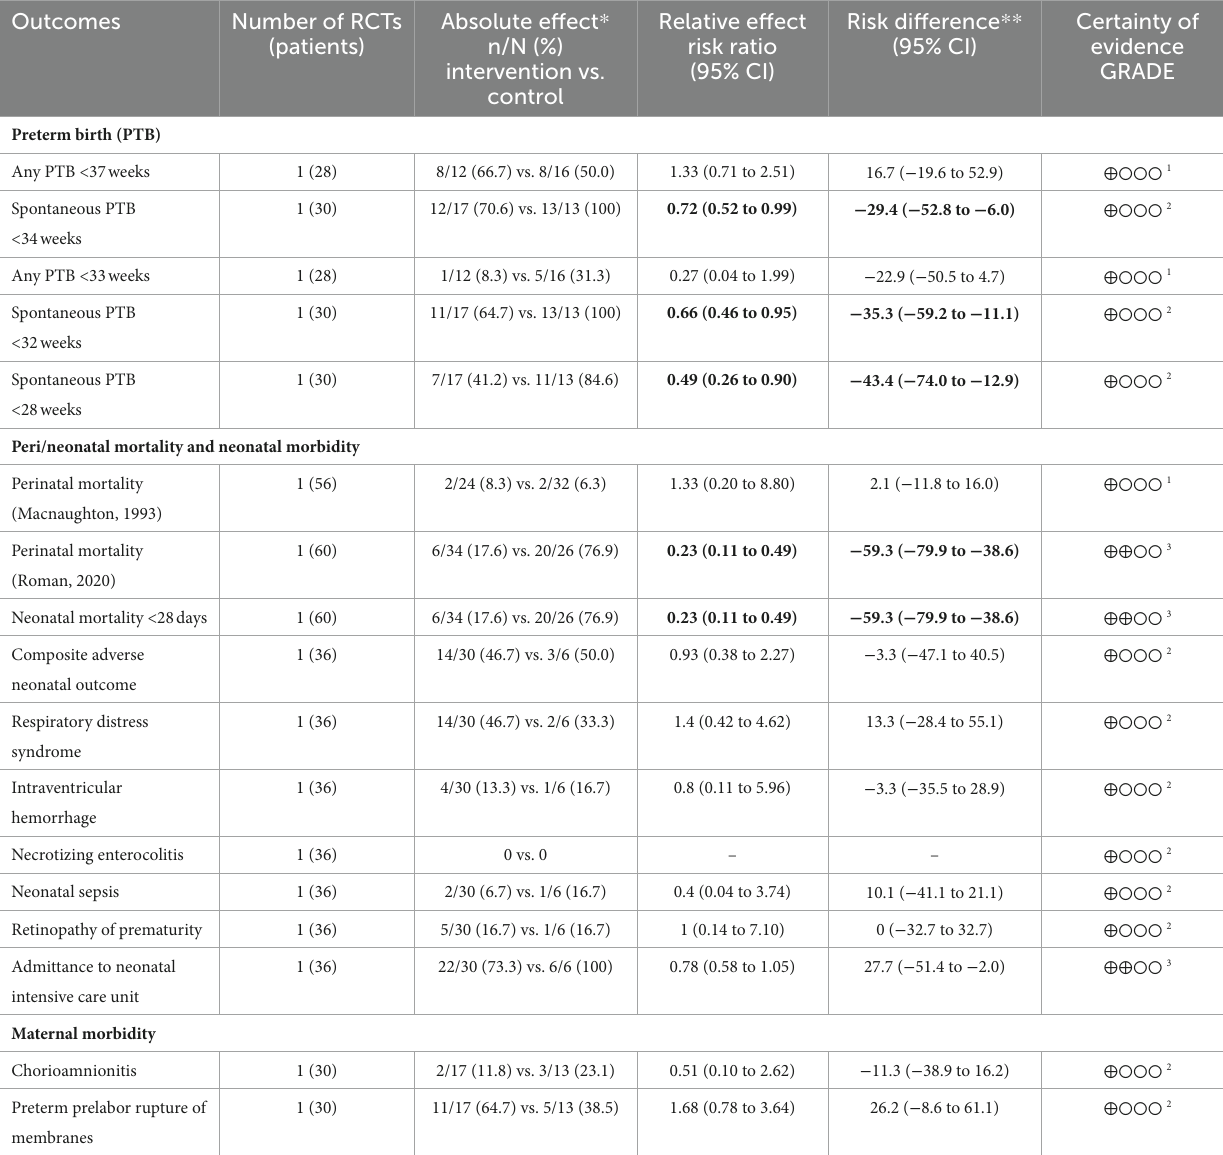
TABLE 7 Summary of findings for main outcomes (based on trials with low risk of bias): Cerclage vs no cerclage in women with a multifetal (twin) pregnancy with or without additional risk